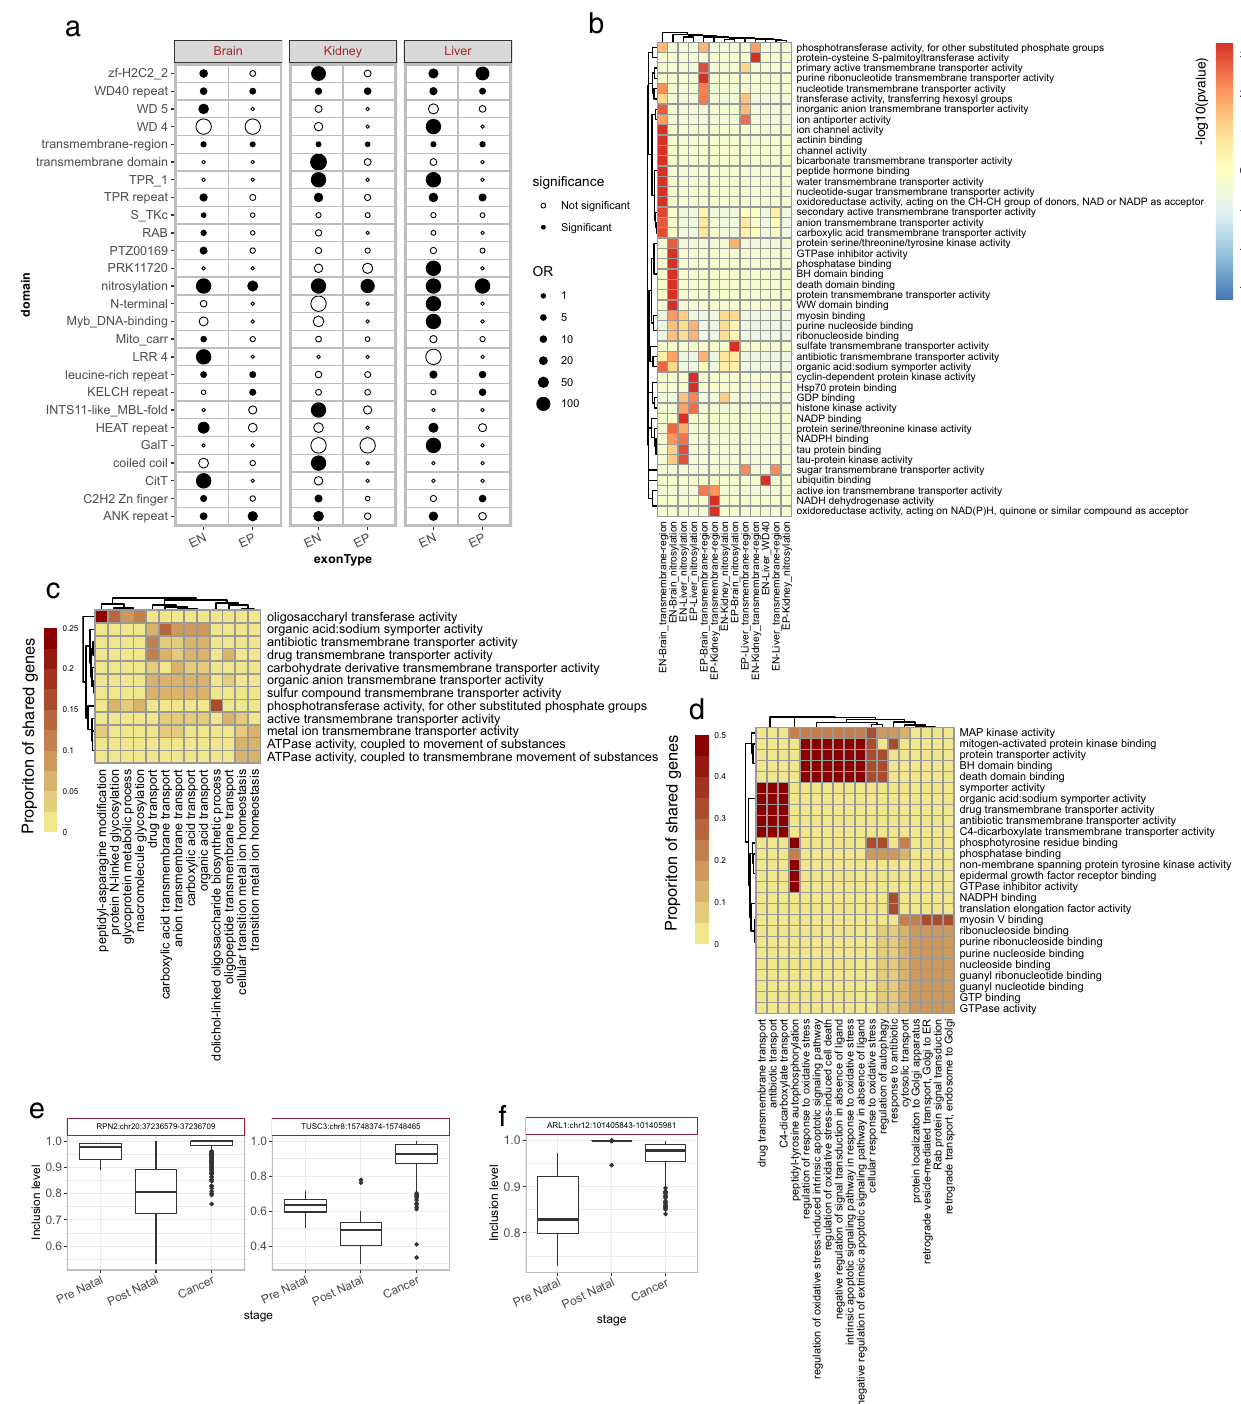
Fig. 3 | Functional assessment of EP and EN exons. a Dot plot showing the enrichment ofdomains in EPand ENevents across three tissues. Sizeof the dots is scaledaccordingtothemagnitudeofoddsratiocalculatedusingFisher ’ sexacttest; solid and hollow dots respectivelyindicate signi fi cant and non-signi fi cant domains based on FDR adjusted two-sided p -value threshold of 0.1. b Molecular functional enrichment across three organs for the host genes of EP and EN events containing nitrosylation, transmembrane-region and WD40 domains (indicated along the columns). The heat colors indicate – log10 of FDR adjusted one-sided p -value of enrichment from Fisher ’ s test as implemented in clusterPro fi ler library in R. c Heatmapshowingthecooccurrenceofenrichedbiologicalprocess(columns)and molecular functions (rows) among the genes containing transmembrane-region